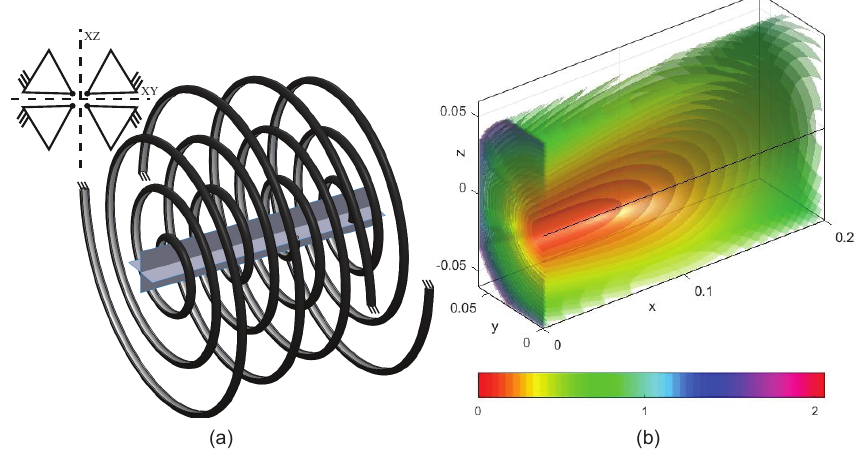
Figure 9. (a) A spiral with U-section and quasi-isotropic material is replicated four times by mirroring about the xy and xz planes. The endpoints are connected through a central shuttle. The spirals have an offset in the x direction to avoid contact. (b) The sum of the PEFs of the components gives the PEF of the whole system. The preferred out-of-plane motion direction exhibited a drift away from the x -axis in the separate components, but is corrected in the assembled system.